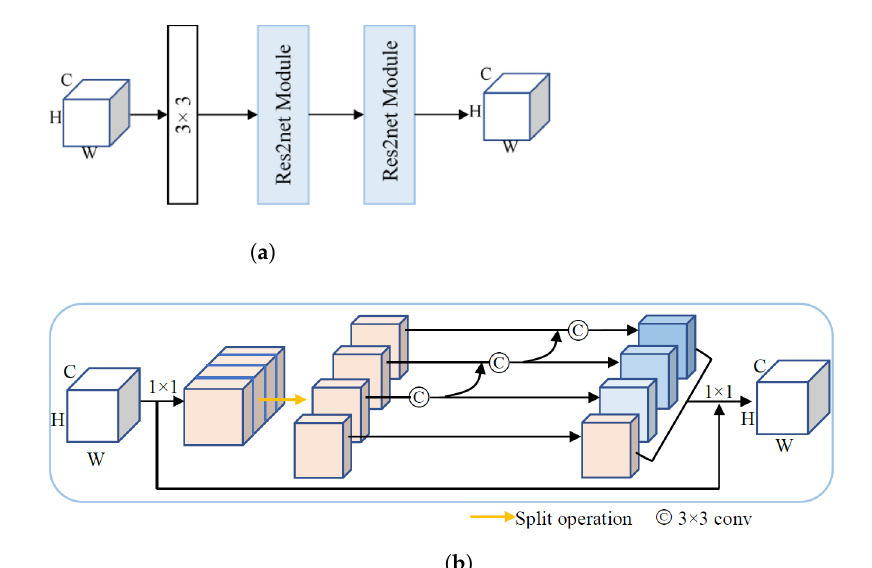
Figure 4. Multi-scale convolution. ( a ) Multi-scale convolution. ( b ) Res2net module structure, where circle C denotes 3 × 3